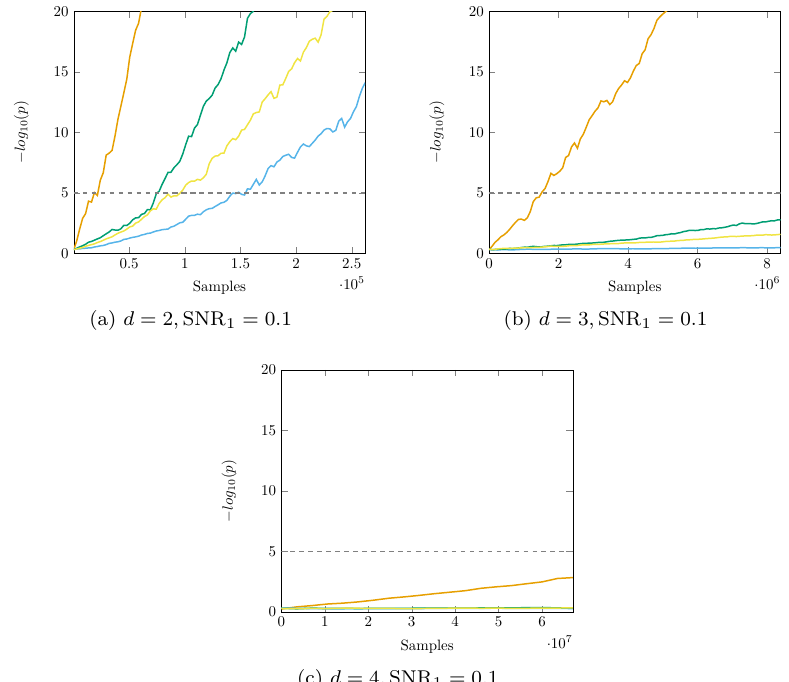
Figure 13: Performance of the (orange) t -test with normalized product, (green) χ 2 -test with normalized product, (yellow) χ 2 -test with sum combining, and (blue) χ 2 -test with multivariate histograms for simulated multivariate 2nd-, 3rd-, and 4th-order leakages with SNR 1 = 0 .